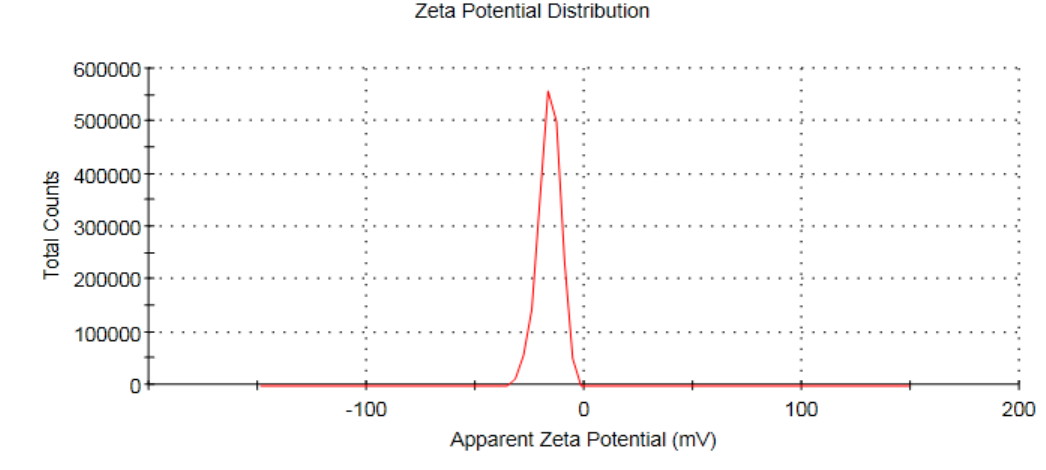
12 of 20 Figure 9. Dynamic light scattering pattern of the biosynthesized silver nanoparticles. The surface charge of the biosynthesized silver nanomaterials was investigated using zeta potential analysis. The estimated zeta potential value of AgNPs was − 16.2 mV (Figure